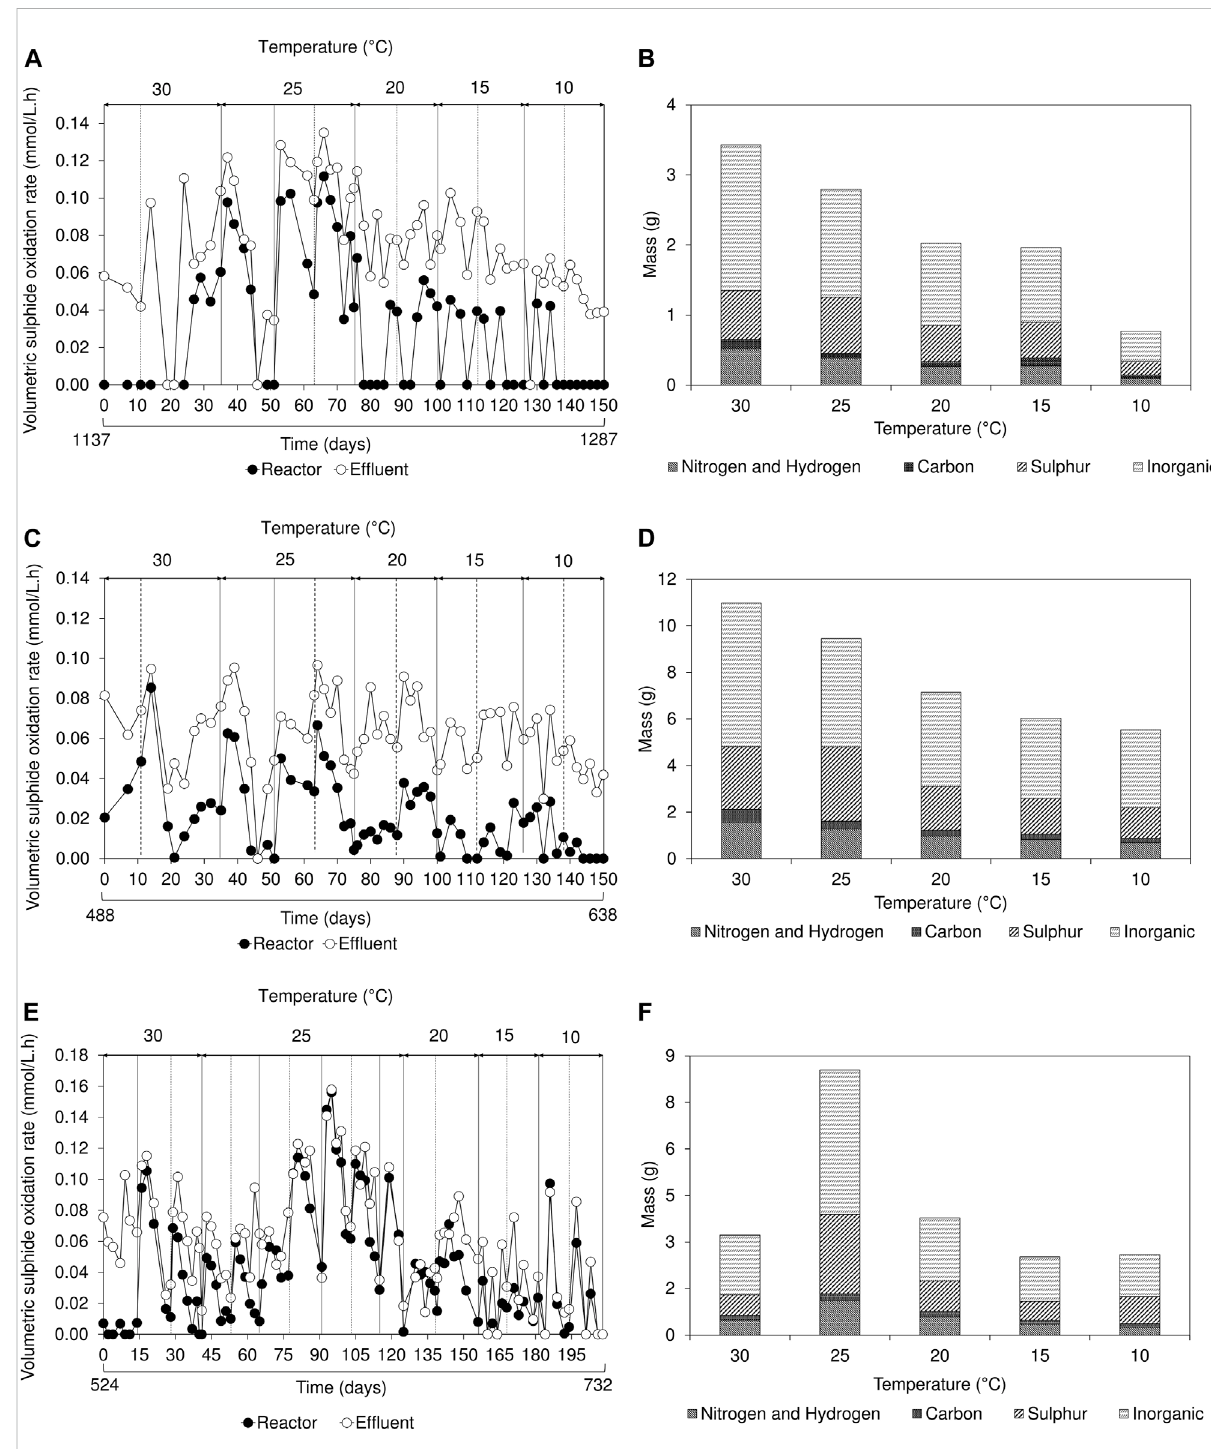
FIGURE 4 Effect of temperature on (A,C,E) volumetric sulphide oxidation rates over time and (B,D,F) fl oating sulphur bio fi lm recovery showing the elemental composition of inorganics, sulphur, carbon, nitrogen, and hydrogen based on the amount (grams) of bio fi lm harvested, in the (A,B) 2 L lactate-fed, (C,D) 8 L lactate-fed and (E,F) 2 L acetate-fed reactors. The inorganic refers to the fraction that was not determined by CHNS